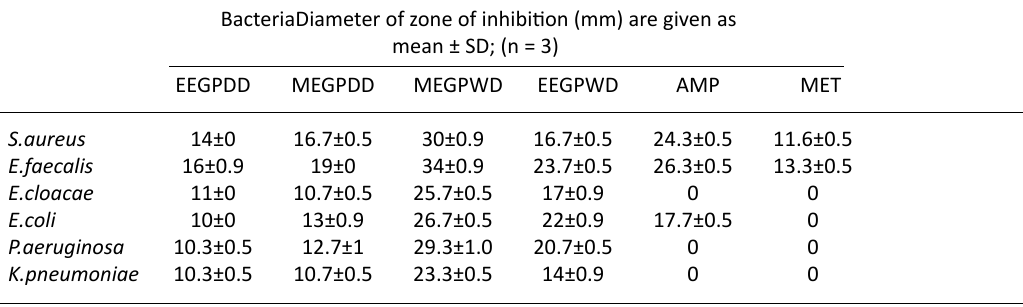
Table 2. Antibacterial activity of G.pedunculata extracts and some of the standard antibiotics against UTI bacterial isolates Bacteria Diameter of zone of inhibition (mm) are given as mean ± SD; (n = 3) MEGPDD